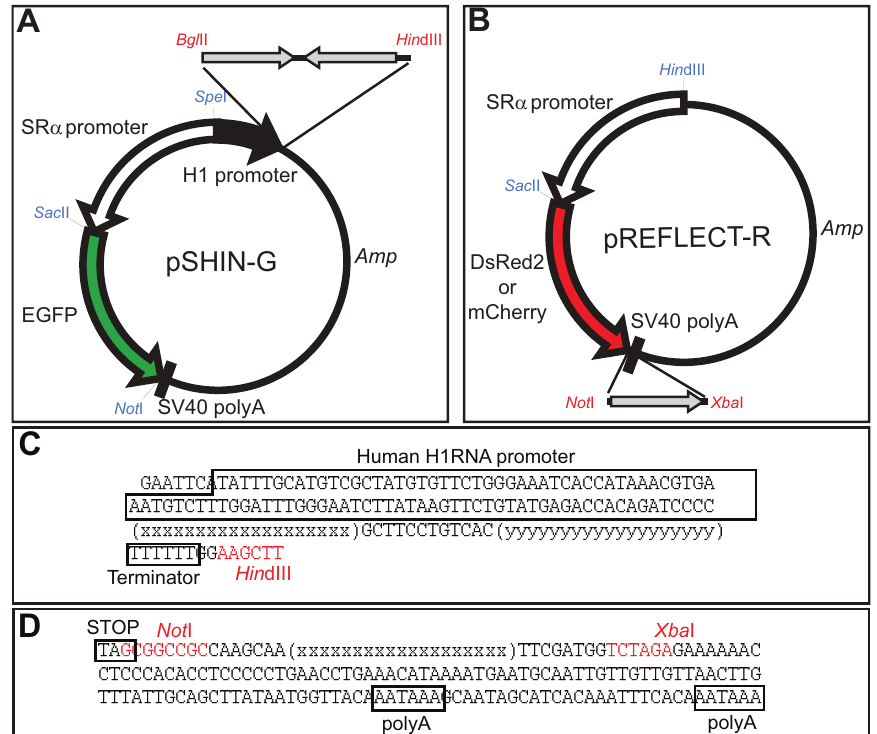
Supplemental Figure 1. Plasmids. ( A ) Map of pSHIN-G plasmid. Annealed oligonucleotides including shRNA sequence were inserted between Bgl II and Hin dIII sites at the downstream of human H1 RNA promoter to make a shRNA expression cassette. EGFP is